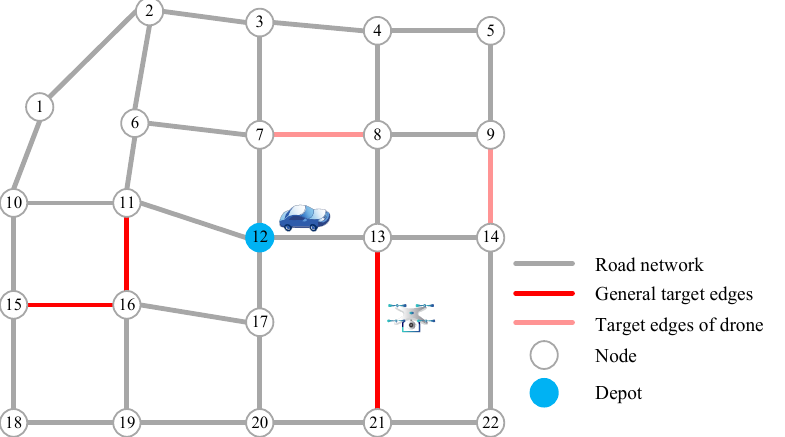
Figure 1. Schematic diagram of road network and target edges, where the numbers 1–22 represent different nodes of the road network.